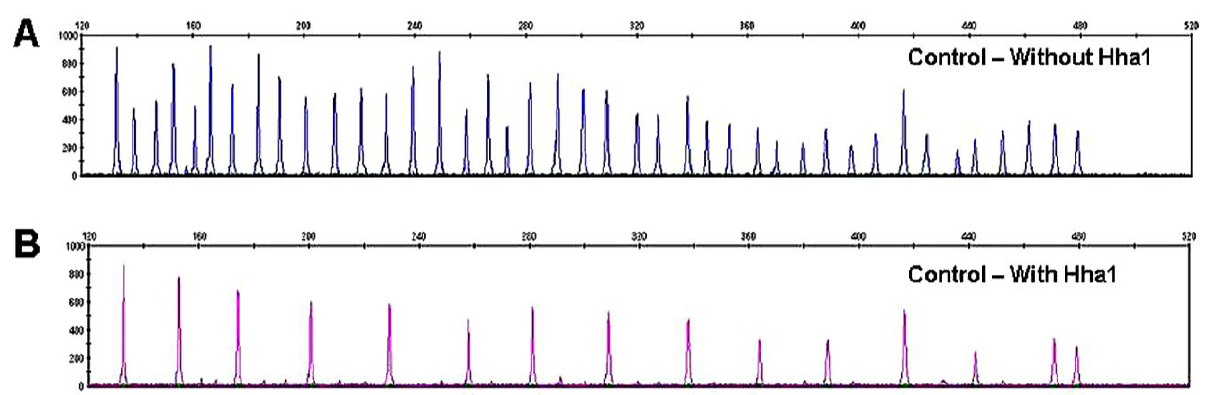
Figure 3. Normal (control) MS-MLPA assay results of MS-MLPA probe mix without ( A ) and with ( B ) Hha I enzyme. Note 15 methylation control peaks in the control DNA sample ( B